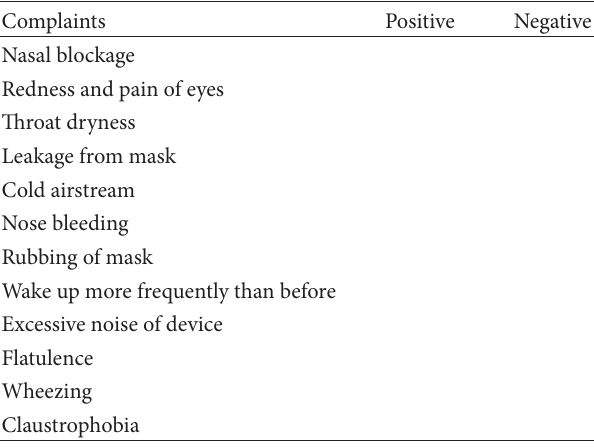
Table 1: Definition of usage time of PAP device and habits of the patients. Usage time (month) Adaptation time to sleep with the device (day) Mean usage time per week (day)